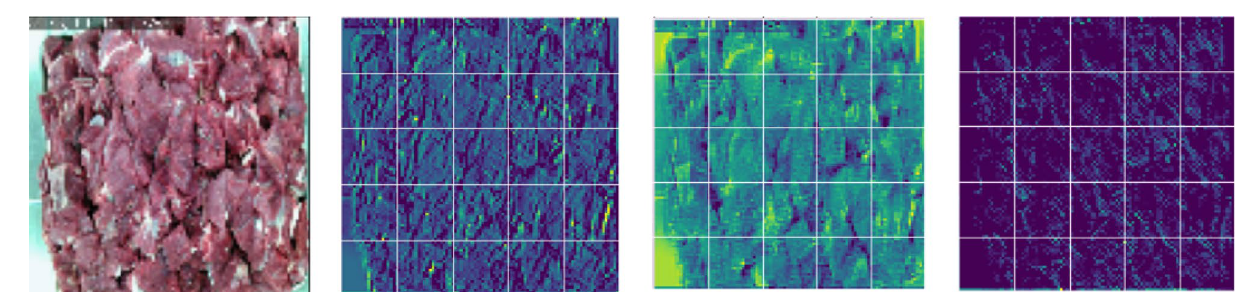
Figure 3. Some outputs of the first convolutional layer. Source: Authors’ construction using Jupyter Notebook, and Python version